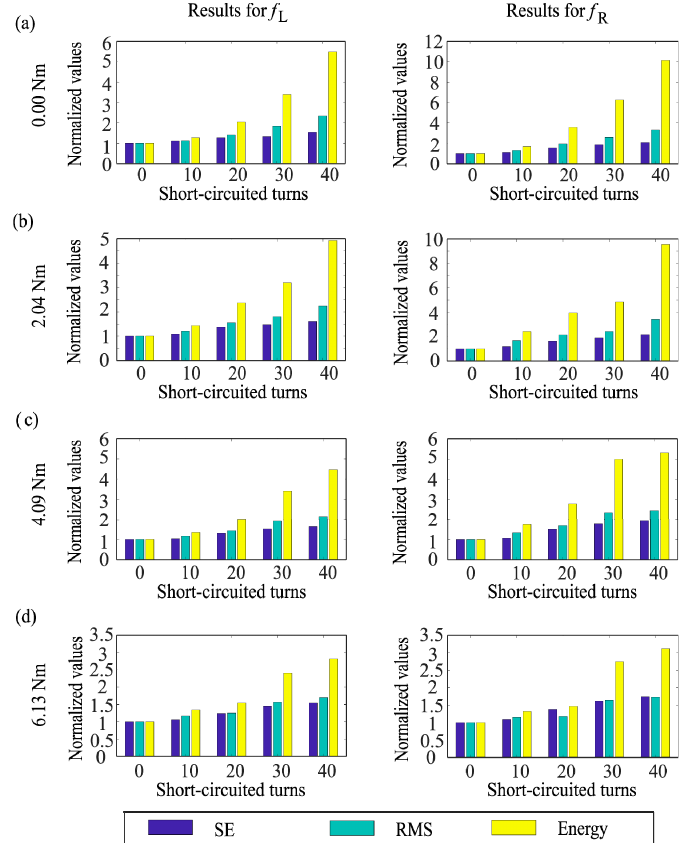
Figure 6. Results for the Shannon entropy (SE), root mean square (RMS), and energy indices at ( a ) 0.00 Nm, ( b ) 2.04 Nm, ( c ) 4.09 Nm and ( d ) 6.13 Nm (left side for f L and right side for f R ).